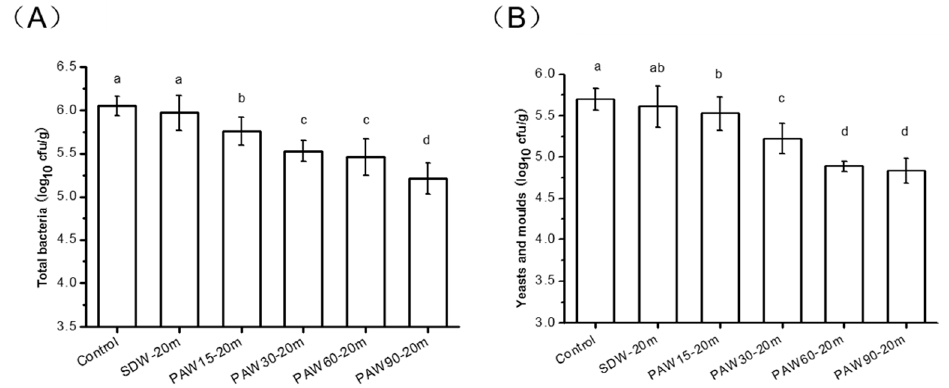
Figure 1. The numbers of surviving bacteria ( A ) and yeasts and molds ( B ) on thin sheets of bean curd before and after plasma-activated water (PAW) treatments with different activation times. Different letters in the bars indicate statistically significant differences ( p < 0.05).